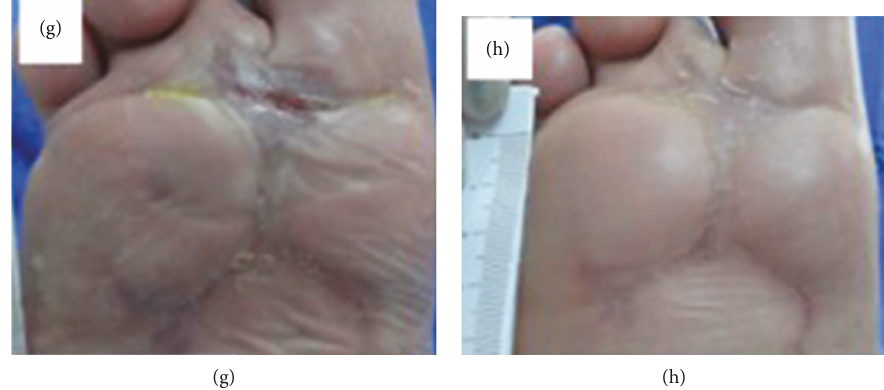
Figure 7: Photo clinical follow-up. Patient 3 (2 ulcer): experimental group: (a) ulcerated foot region; (b) early (before the tissue neoformation-inducing system); (c) posttreatment (after using the tissue neoformation-inducing system) (1 week); (d) 2 weeks; (e) 3 weeks; (f) 4 weeks; (g) 5 weeks; (h) 6 weeks. This fi gure is reproduced from Reis [42], public domain.